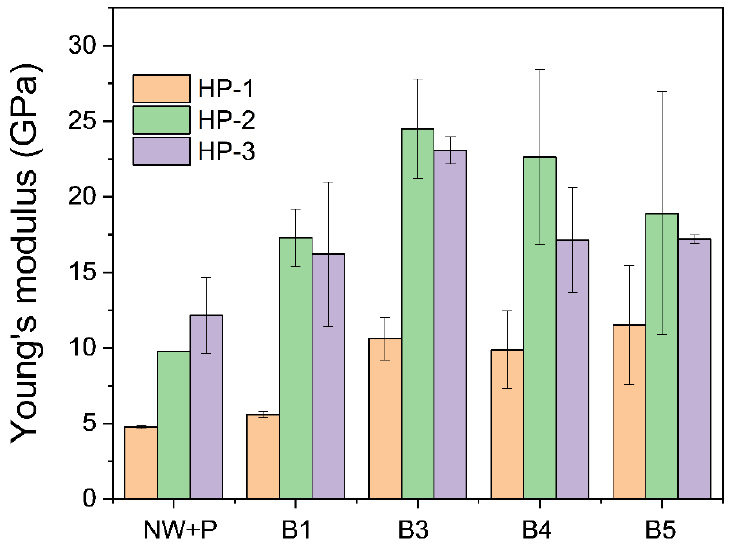
Figure 8. Young’s modulus of CW specimens prepared by various bleaching and hot-pressing con-